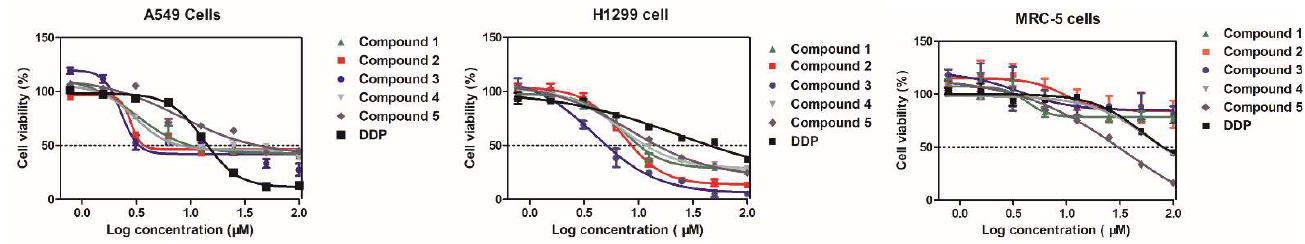
Figure 5. Antiproliferative activity of compounds 1 – 5 against two NSCLC cell lines (A549 and H1299) as well as non-cancer MRC-5